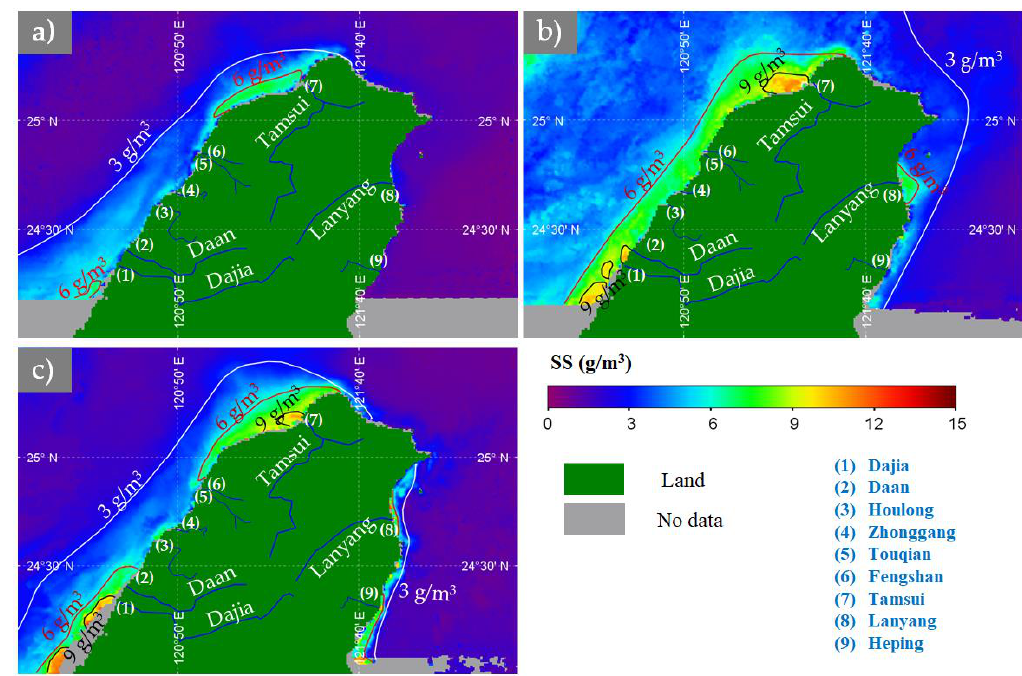
𝑆𝑆̅̅̅ 𝑆𝑆̅̅̅ 𝑆𝑆̅̅̅ 4−7 ; ( b ) 11−14 ; ( c ) 19−22 .